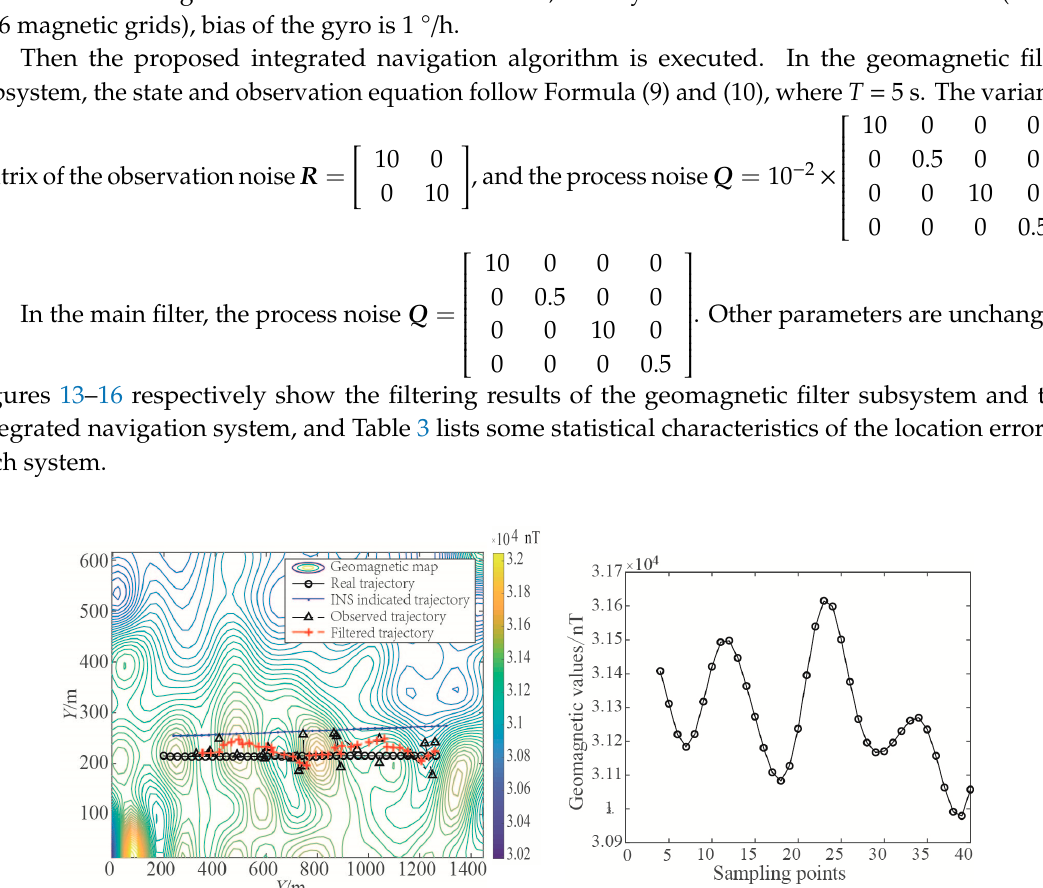
Figure 14. Total error after geomagnetic filtering.